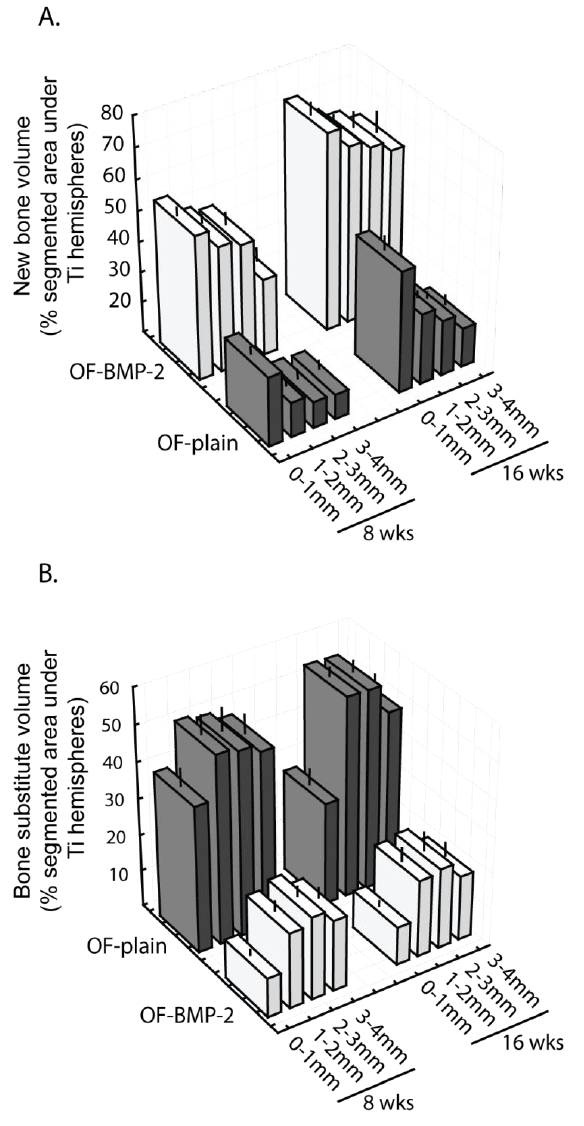
Figure 6. New bone volume ( A ) and bone substitute volume ( B ) under the hemispheres, segmented in 4 horizontal planes of 1 mm in height at 8 weeks and 16 weeks in OF-plain (grey) and OF-BMP-2 (white) samples. ( n = 8 for each column). (Bars = SEM, OF-plain: bare construct; OF-BMP-2: BMP-2 primed